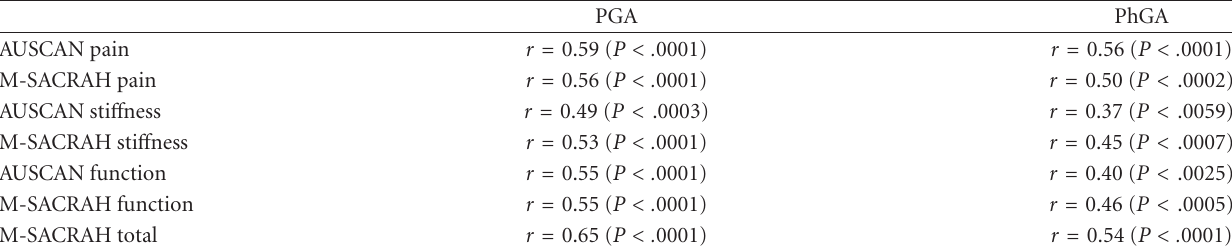
Table 5: Correlations of single domains and total M-SACRAH with PGA/PhGA.